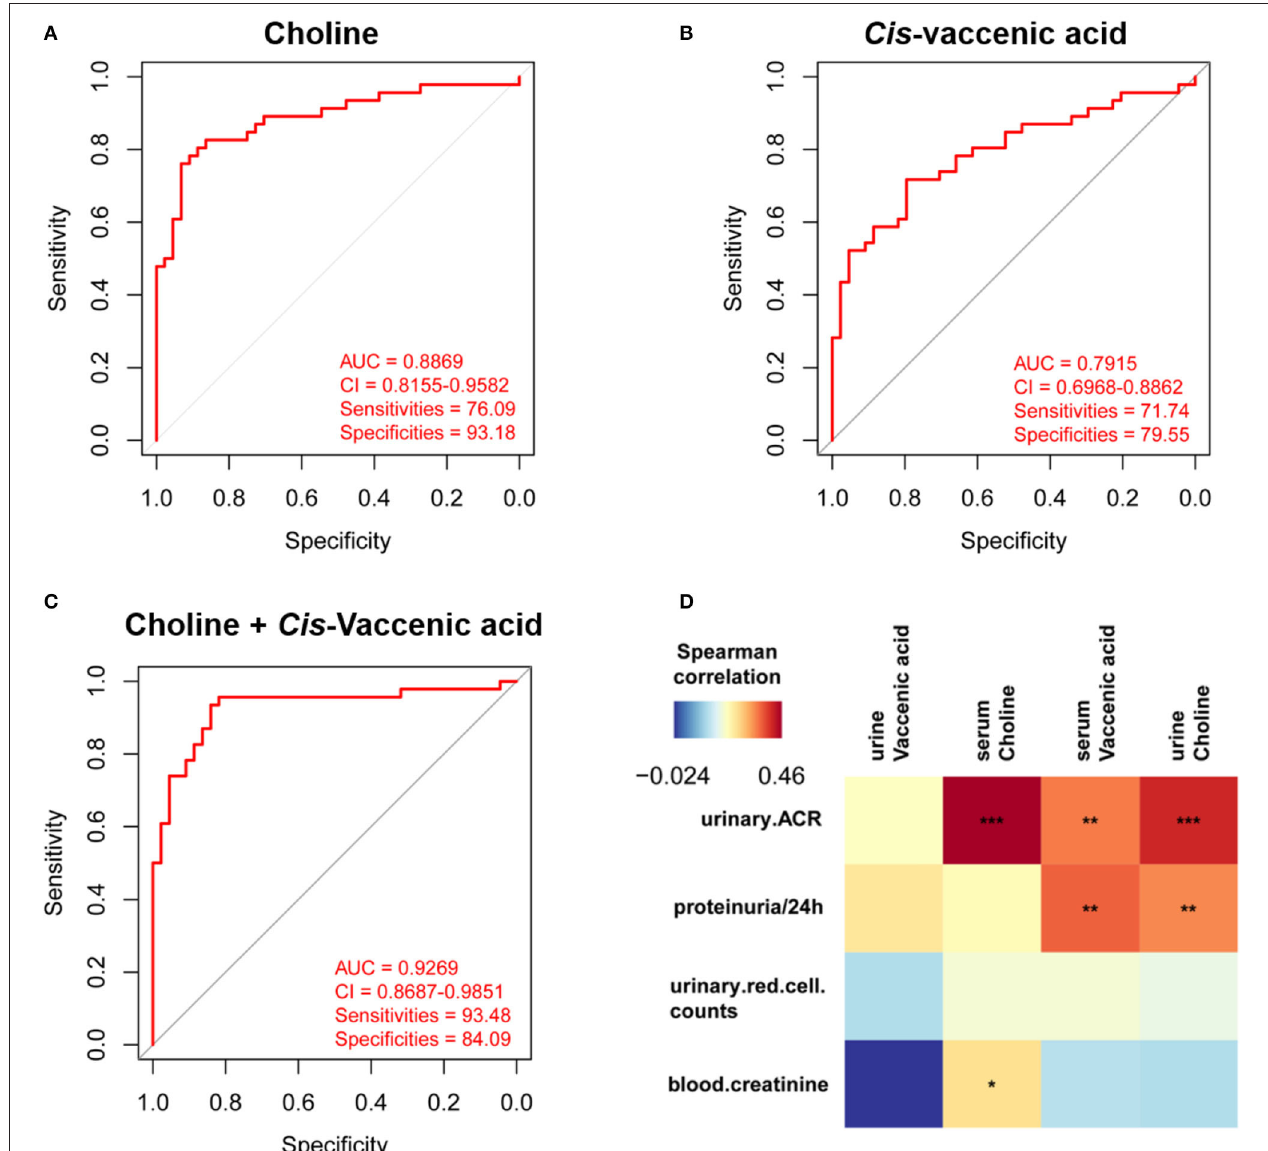
FIGURE 4 | Differential diagnosis and correlation analysis of the metabolic biomarkers. ROC analysis of (A) choline, (B) cis -vaccenic acid, and (C) the combination of choline and cis -vaccenic acid for HSPN ( + ) vs. HSPN (–) in serum. (D) Correlation analysis of HSPN clinical indices and metabolic markers (choline and cis -vaccenic acid) in serum and urine. Color units denoted the value of Spearman correlation coefficient. The red color indicates a positive correlation and the blue represents a negative correlation. * p < 0.05, ** p < 0.01, and *** p < 0.001. ROC, receiver operating